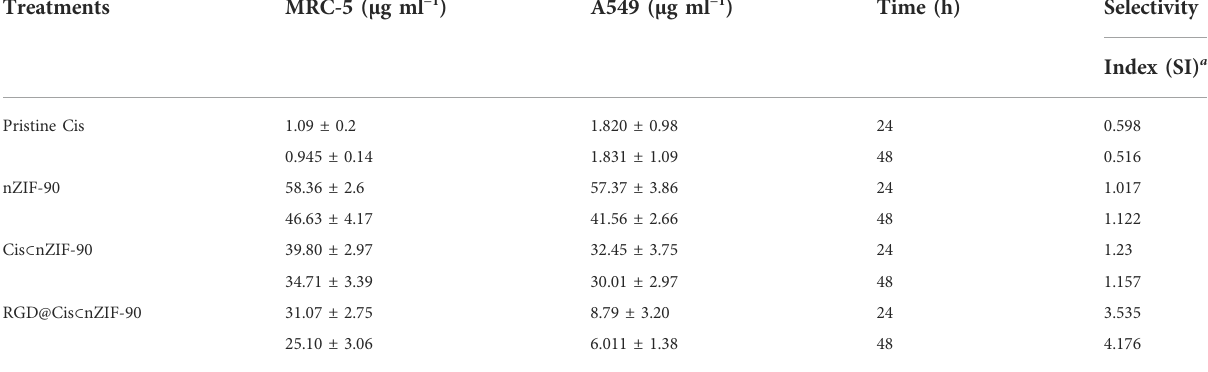
TABLE 1 IC 50 values for pristine Cis, nZIF-90, Cis ⊂ nZIF-90, and RGD@Cis ⊂ nZIF-90 against MRC-5 and A549.